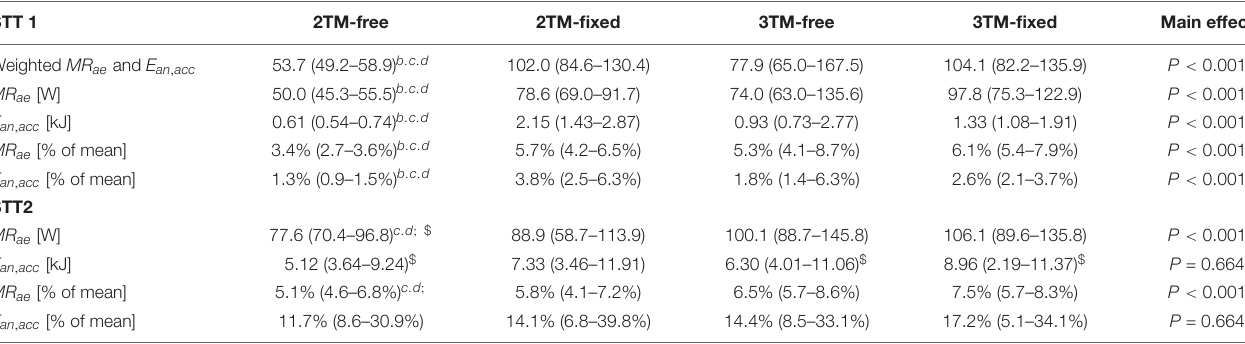
TABLE 2 | The median and interquartile range (IQR) of root mean square error (RMSE) for the aerobic metabolic rate and accumulated anaerobic energy expenditure in absolute and relative numbers for STT1 and STT2. Also reported is the weighted RMSE of MR ae and E an , acc as described in section “Parameter Estimation”. STT 1 2TM-free